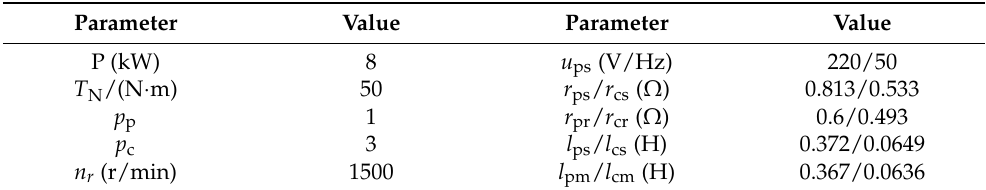
Table 1. BDFM parameters [25].